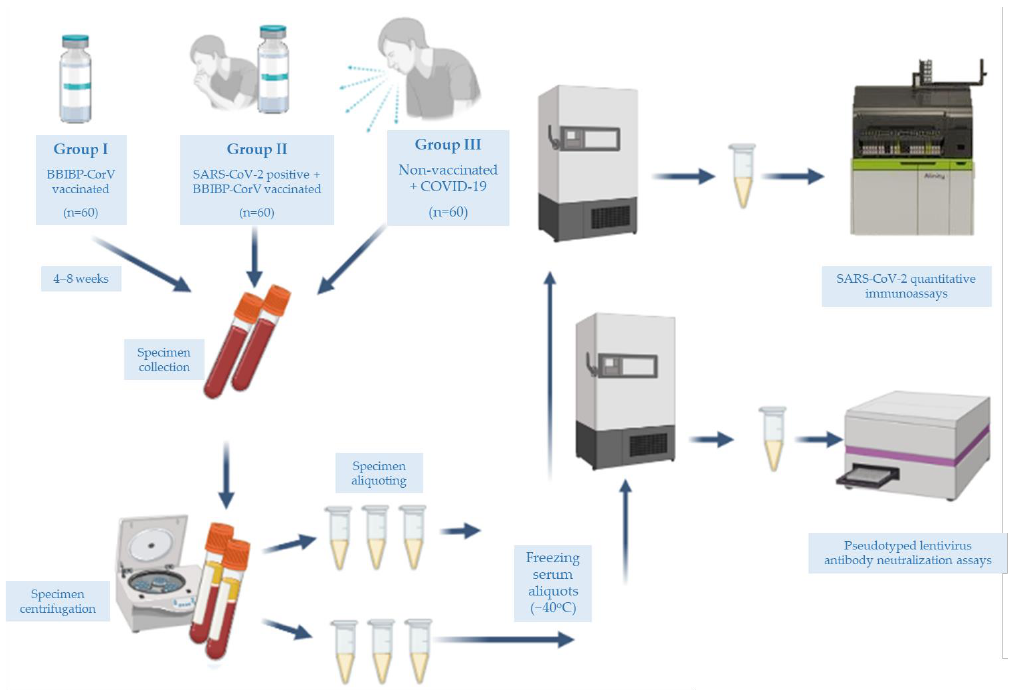
Figure 1. Study scheme showing the categorization of study groups, flow of specimens, and their storage until the final analysis by two different assays (image partly created in BioRender.com).